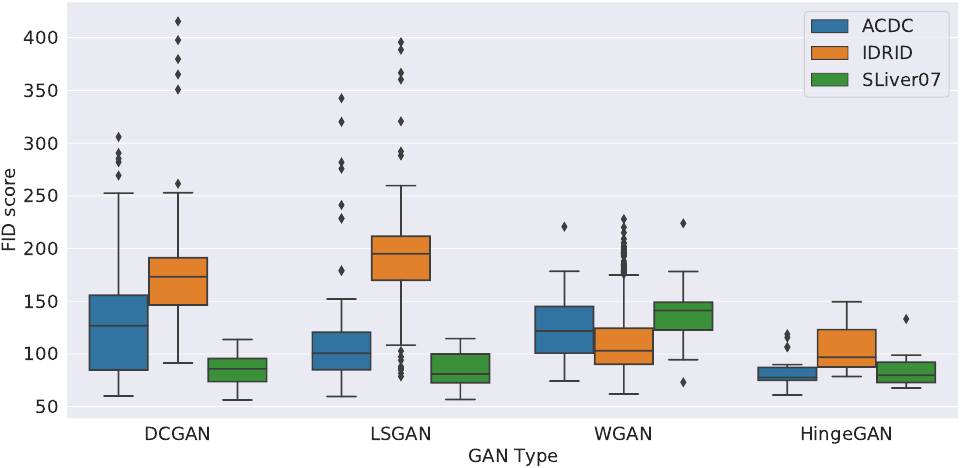
Figure 5. FID score for different GAN types on the IDRiD, ACDC, and SLiver07 datasets, across different hyperparameter